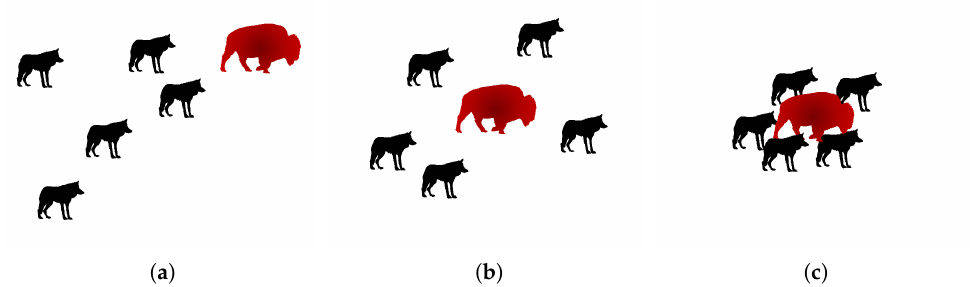
Figure 2. Group hunting process of grey wolves in a pack ( a ) prey tracking, ( b ) prey encircling, and ( c ) prey